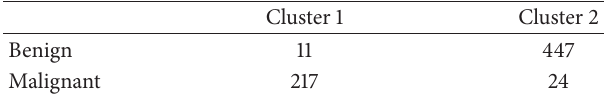
Table 4: Confusion matrix for the average clustering result with Ahmad and Dey [22] distance measure, for 𝑚 = 1.1 .